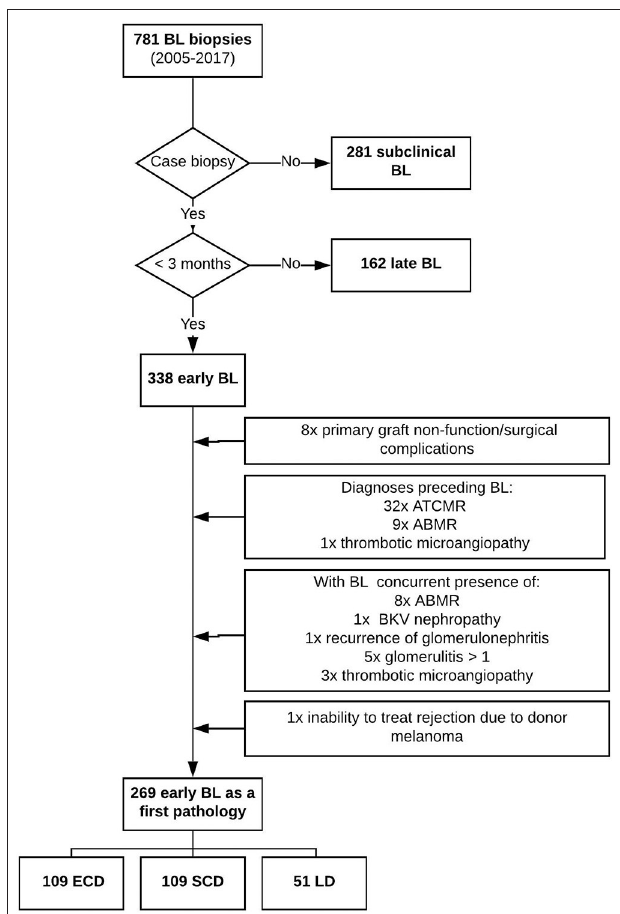
FIGURE 1 | Flowchart of the study.